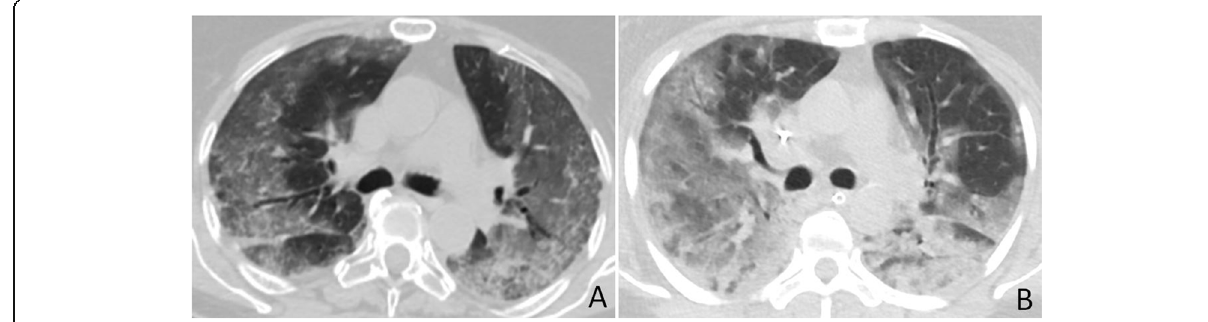
Fig. 1 COVID-19 and MERS pneumonia misdiagnosed as COVID-19. a A 69-year-old man with positive PCR test for COVID-19; axial HRCT image shows peripheral and central GGO with superimposed interlobular septal thickening, bronchial dilatation, and pleural thickening. b Axial CT image of a 50-year-old man with a positive PCR for MERS shows similar findings as a with posteriorly located consolidations in the right lung